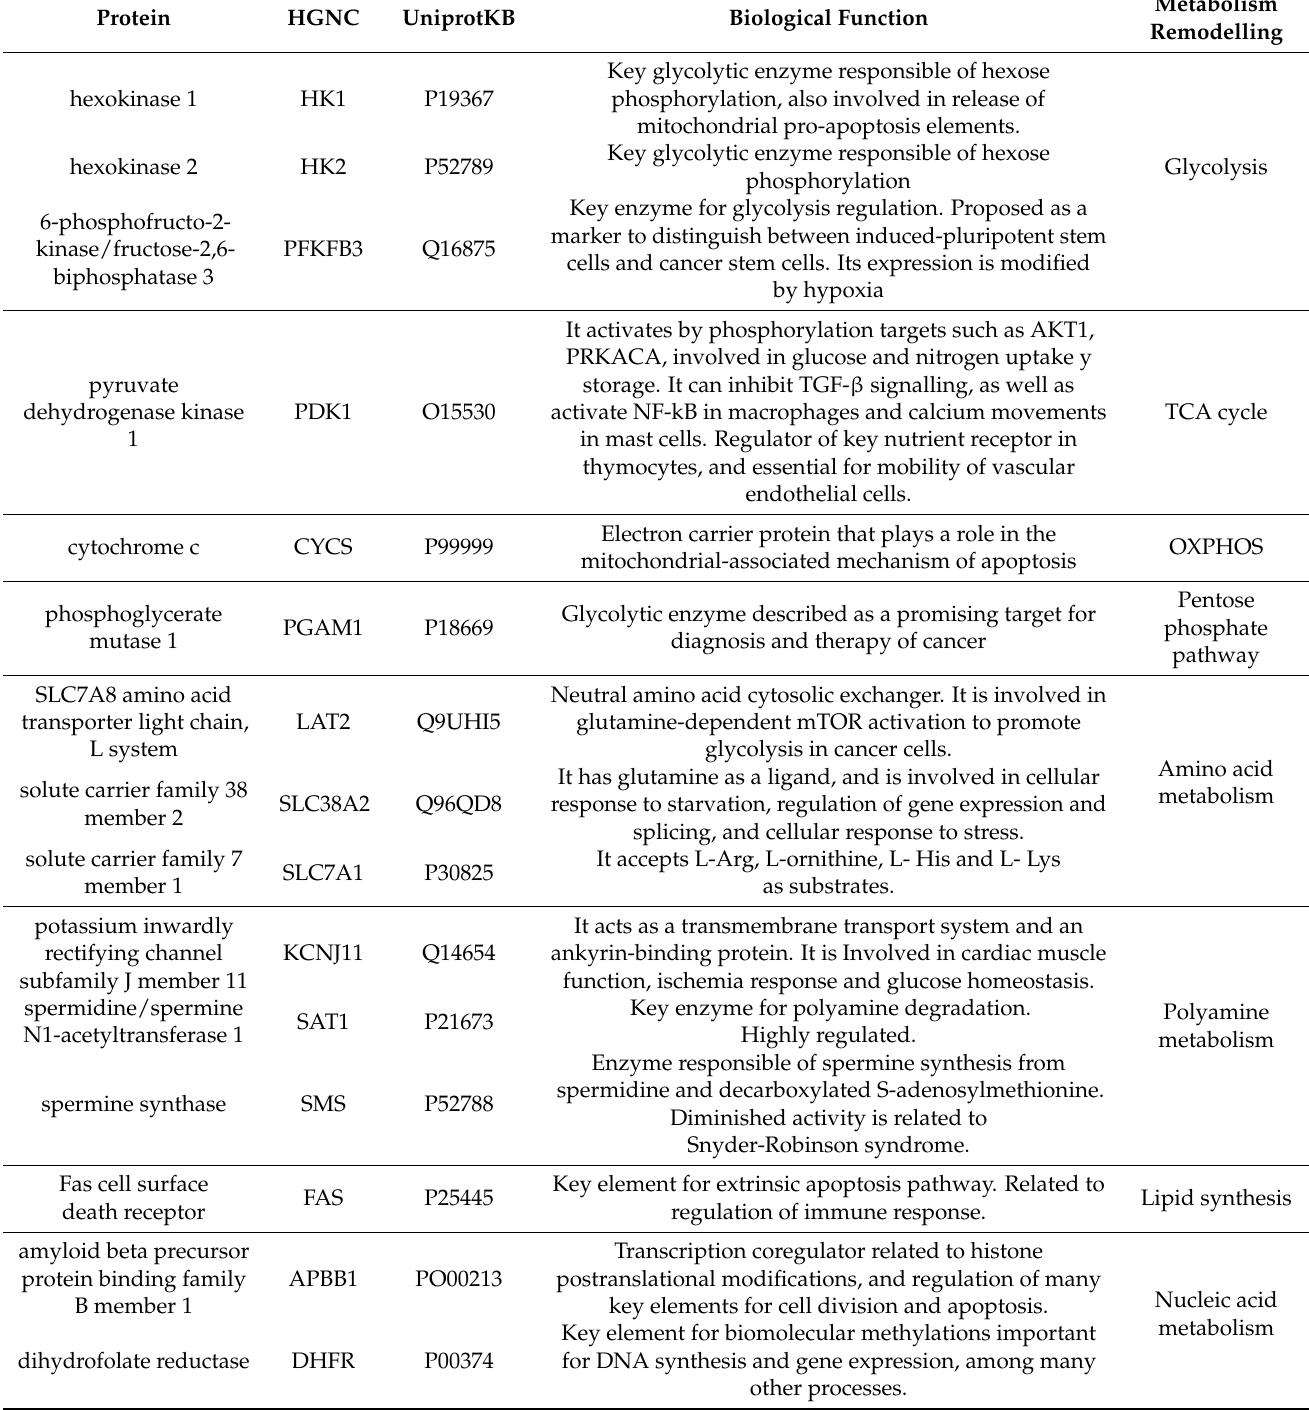
Table 2. A synthesis of biochemical characteristics of metabolic remodelling-related targets modified by histamine through H1-H4